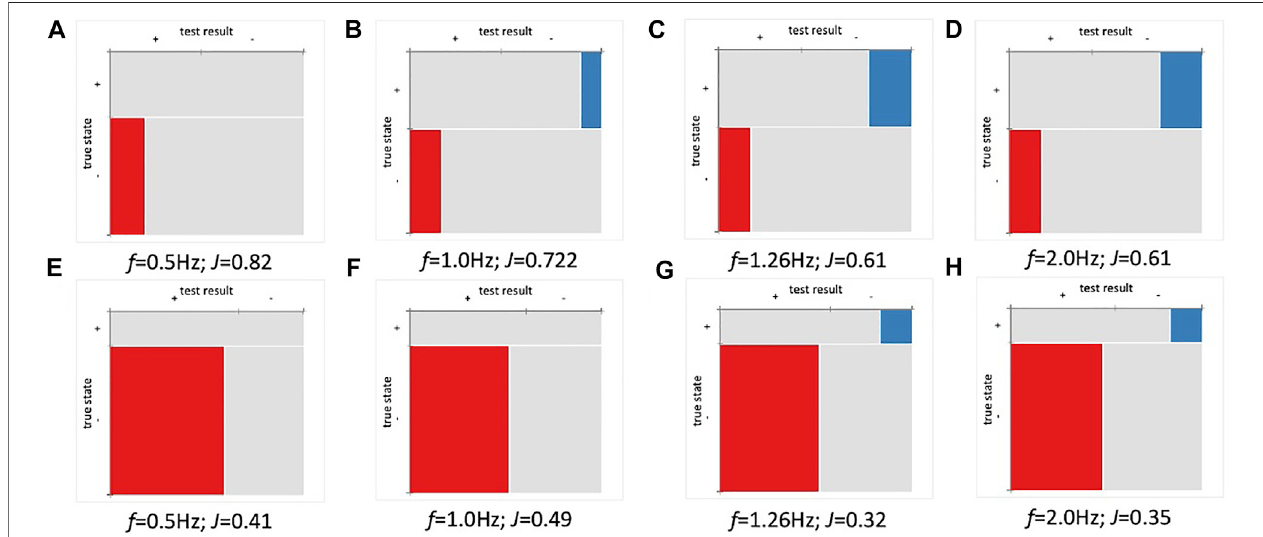
FIGURE 5 | Positive percent agreement (PPA) and negative percent agreement (NPA) of ACE2 detector for SARS-CoV-2 (Delta) at various frequencies ( n = 36). Youden index (J) and cutoff frequency ( f ) shown for each plot. (A – D) Mosaic plot for detection of Delta variant (0-1,000 copies/ml). (E – H) Mosaic plot for Delta (0-1,000 copies/ml) variant including matrix and negative controls. The threshold was set using baseline